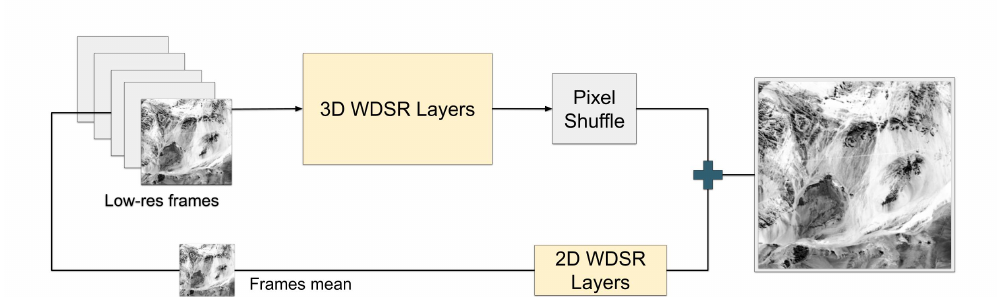
Figure 2. 3DWDSRnet: All low-resolution input frames are fed into the main WDSR Conv 3D path to predict the scene’s residuals.The average of the frames is used as the input to the WDSR 2D Convs path. The results of both paths are added together to obtain the final HR frame. Soft yellow highlights the differences with the original 3DSRnet blocks.